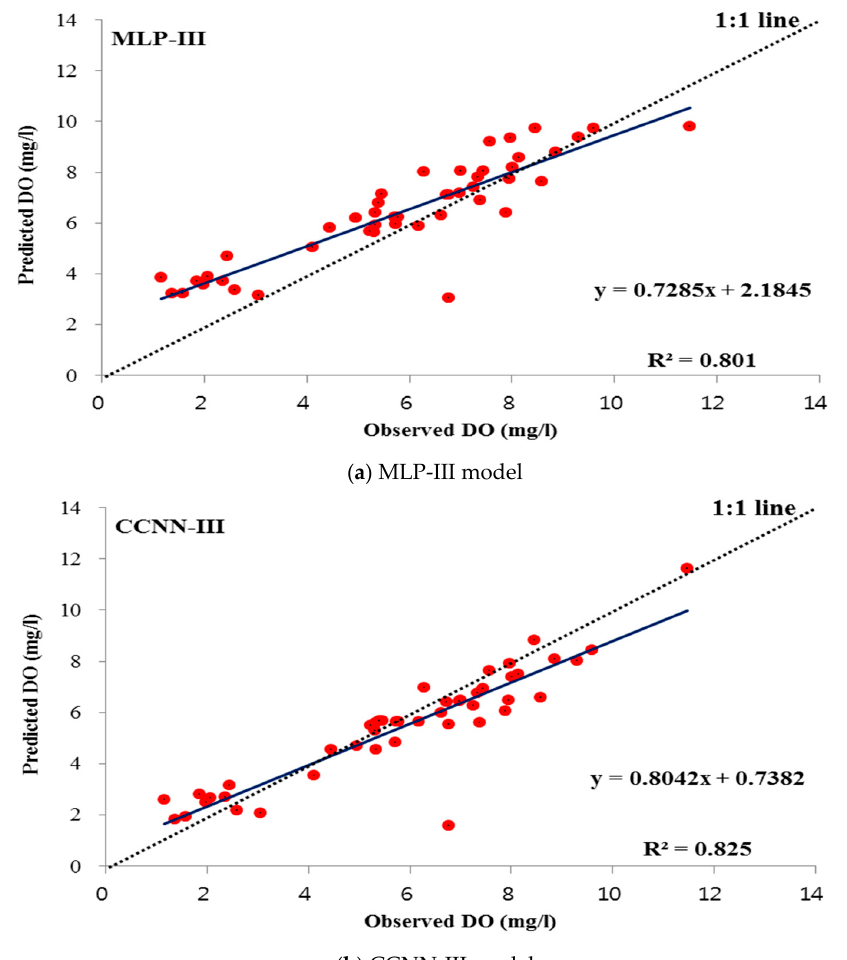
Figure 7. Scatter plots of observed and predicted DO values using standalone models for the testing phase.